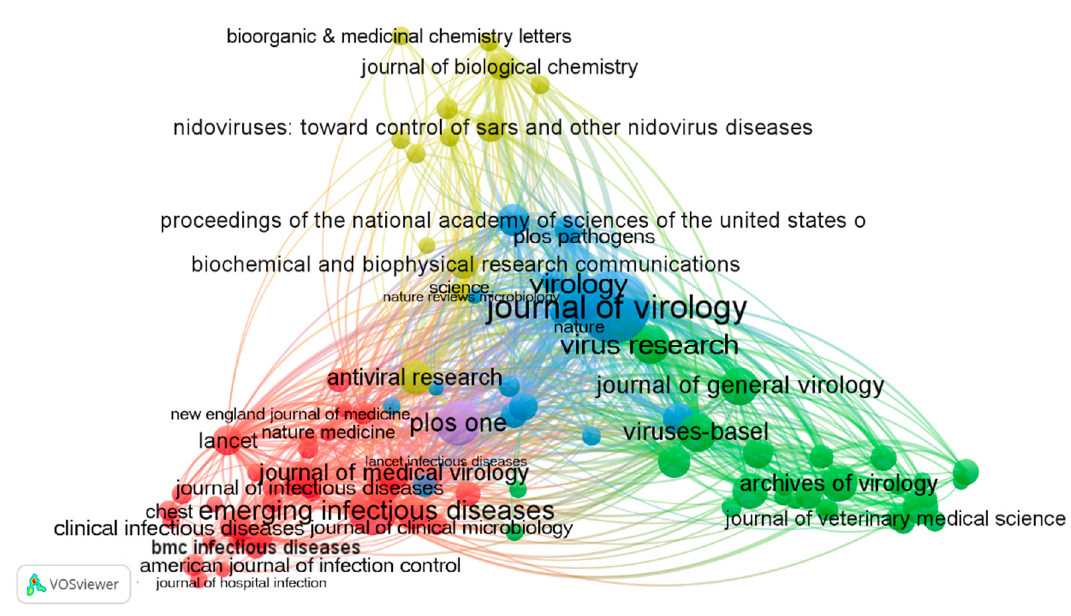
Figure 7. Documents and citation network of journals.